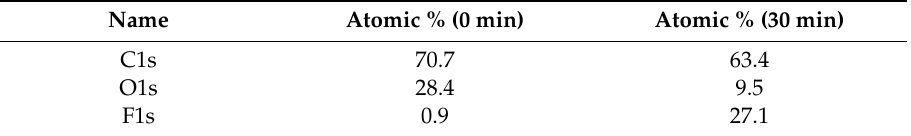
Figure 2. X-ray photoelectron spectroscopy (XPS) images of samples with different plasma etching Figure2. X-ray photoelectron spectroscopy (XPS) images of samples with di ff erent plasma etching durations. durations. Table 1. Atomic percentages of sample surfaces with di ff erent plasma etching Table 1. Atomic percentages of sample surfaces with different plasma etching durations.